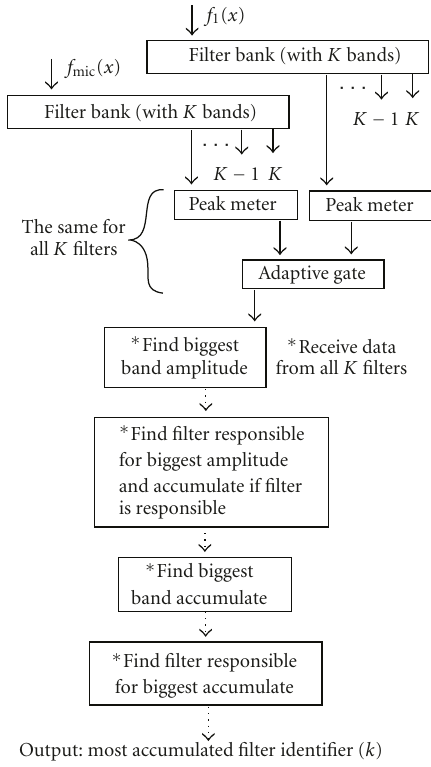
Figure 4: Analysis block diagram for one input channel.